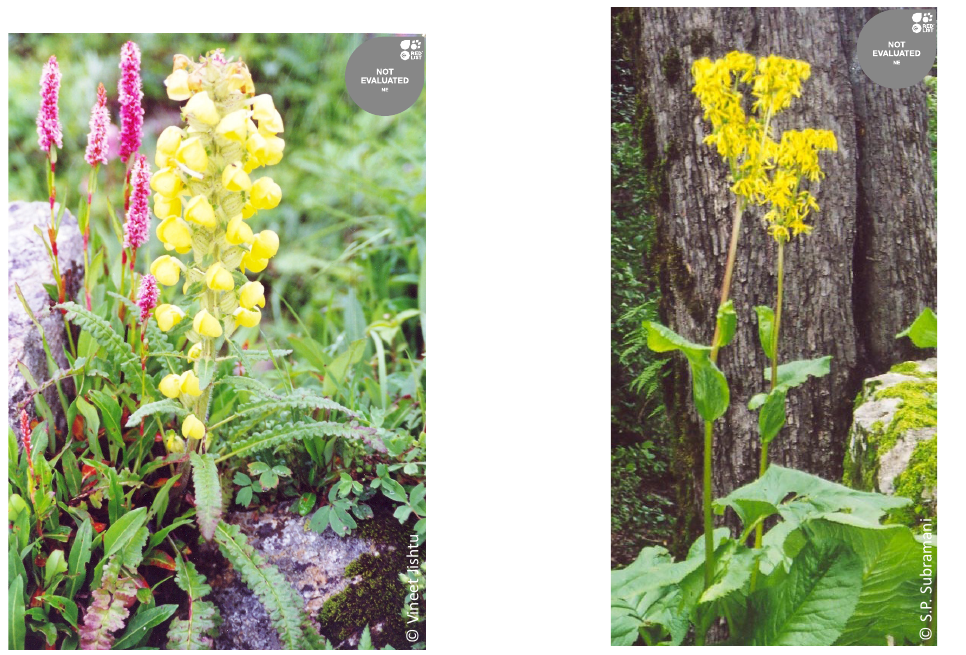
Image 48. Pedicularis bicornuta Klotzsch Image 49. Ligularia amplexicaulis